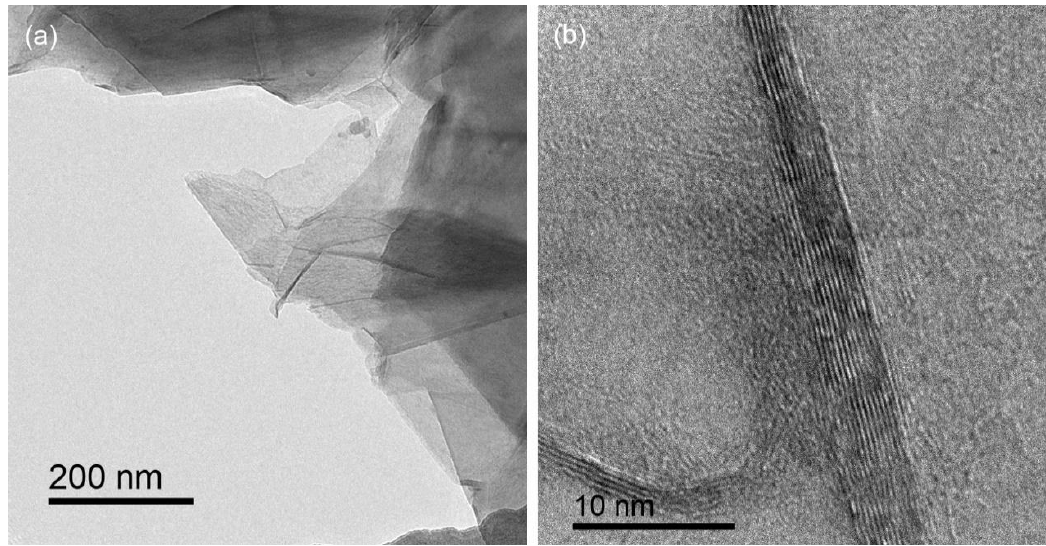
Figure 4. Transmission electron microscope (TEM) images of GN, indicating the ( a ) microstructure and ( b ) thickness.